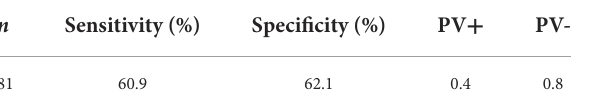
TABLE 4 Sensitivity and specificity of SARC-F with predictive values according to